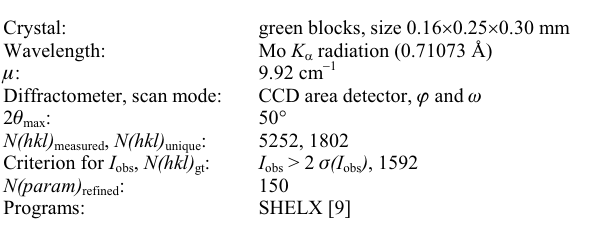
Table 1. Data collection and handling.